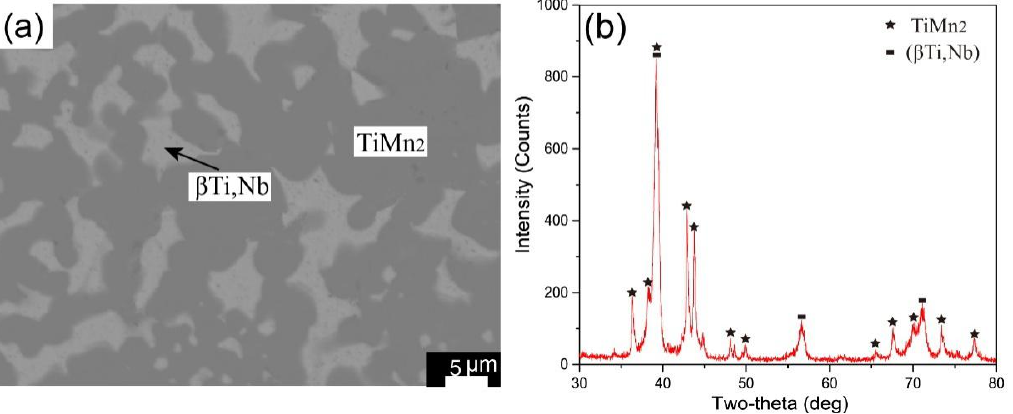
Figure 7. Alloy A2 annealed at 1173K for 90 days: ( a ) back-scattered electron (BSE) images, ( b ) XRD patterns.